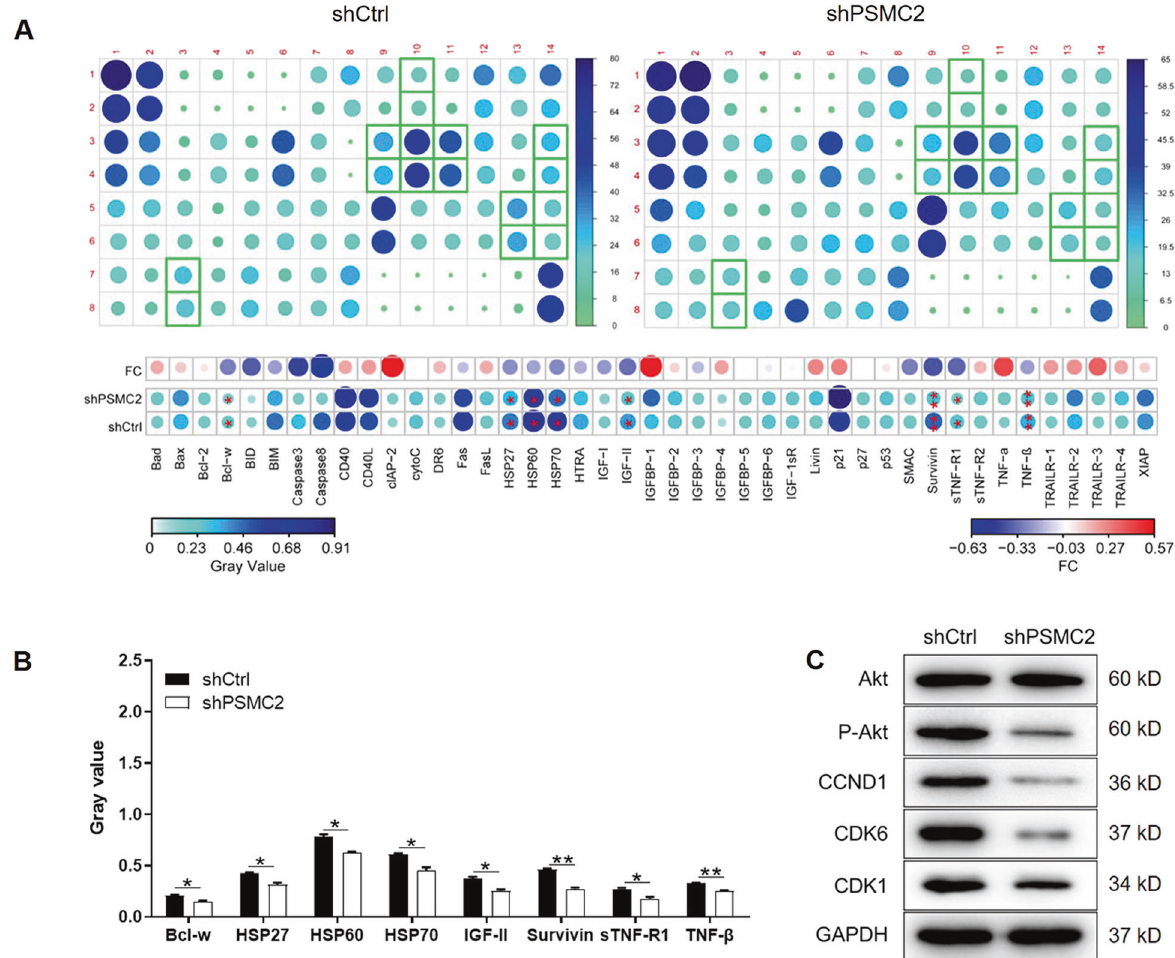
Fig. 3 PSMC2 regulates ovarian cancer cell apoptosis through regulating apoptosis-related proteins and Akt pathway. A An apoptosis antibody array was used to detect the differential expression of 43 apoptosis-related proteins in shPSMC2 and shCtrl cells. B 8 of the 43 apoptosis-related proteins were signi fi cantly downregulated in shPSMC2 cells. C The expression of Akt, p-Akt, CCND1, CDK6 and CDK1 in shPSMC2 and shCtrl cells was detected by western blotting. Data were presented as mean ± standard deviation based on at least 3 independent experiments. * P < 0.05, ** P <